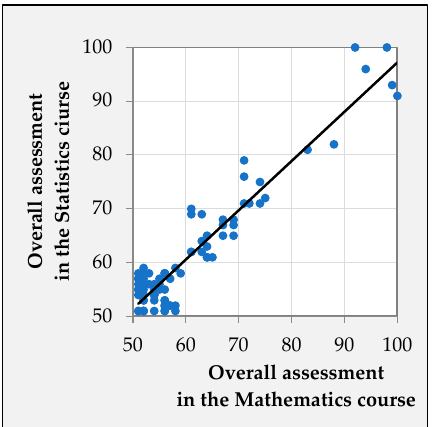
Figure 8. The relationship between the overall student assessments in points in the Statistics course and the Mathematics course. Table 3. Overview of student success rates in individual years of